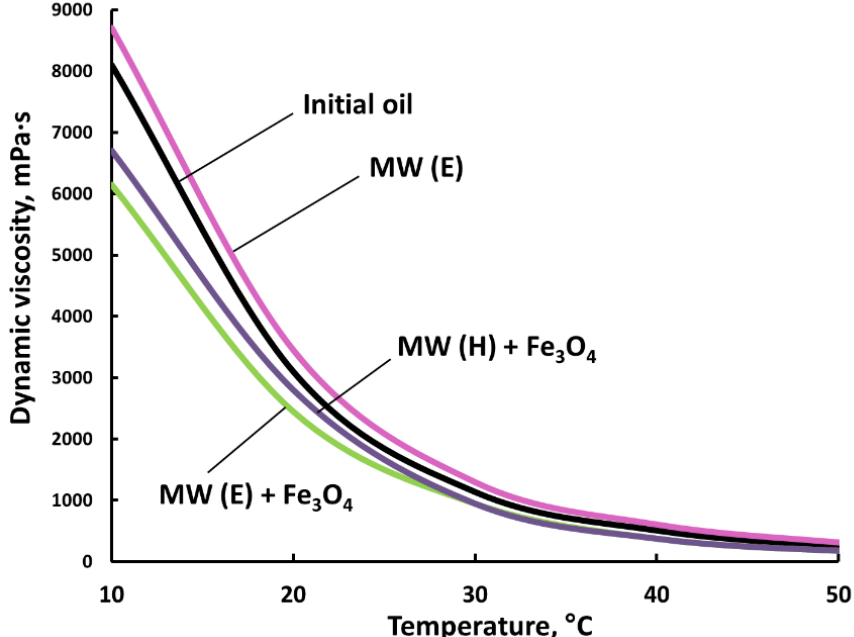
Figure 3. Oil viscosity dependence on temperature before and after MW processing.